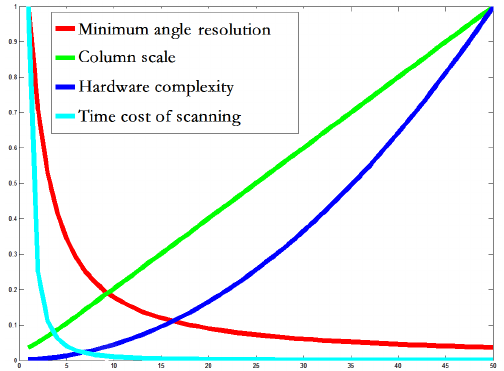
Figure 3. The relations to the complexity of logical RF in the architecture. The x -axis is the RF size of a column modular and the y -axis is normalized to adapt four different values: minimum angle resolution, RF size of a column, the total hardware complexity, and the time cost of scanning. Based on these four curves, we can find one or several balance points, at which the performance is not optimal but its corresponding cost is relatively low in the proposed